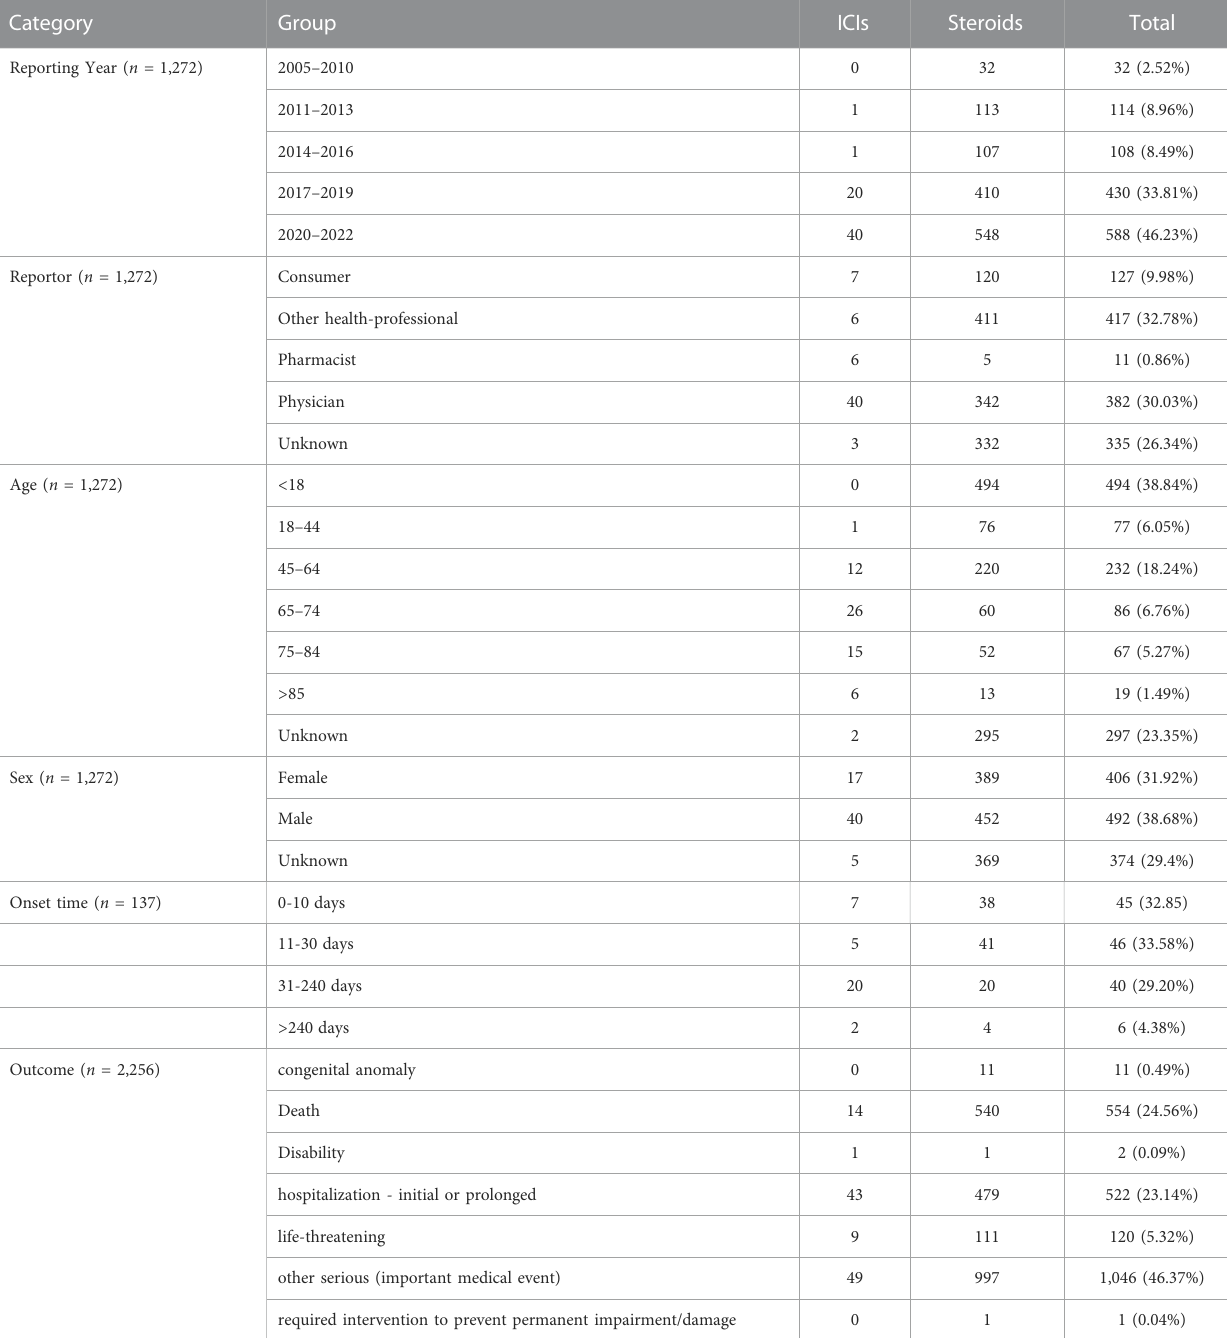
TABLE 2 The demography and patient information of ICIs-related or steroids-related pneumatosis intestinalis in FAERS.